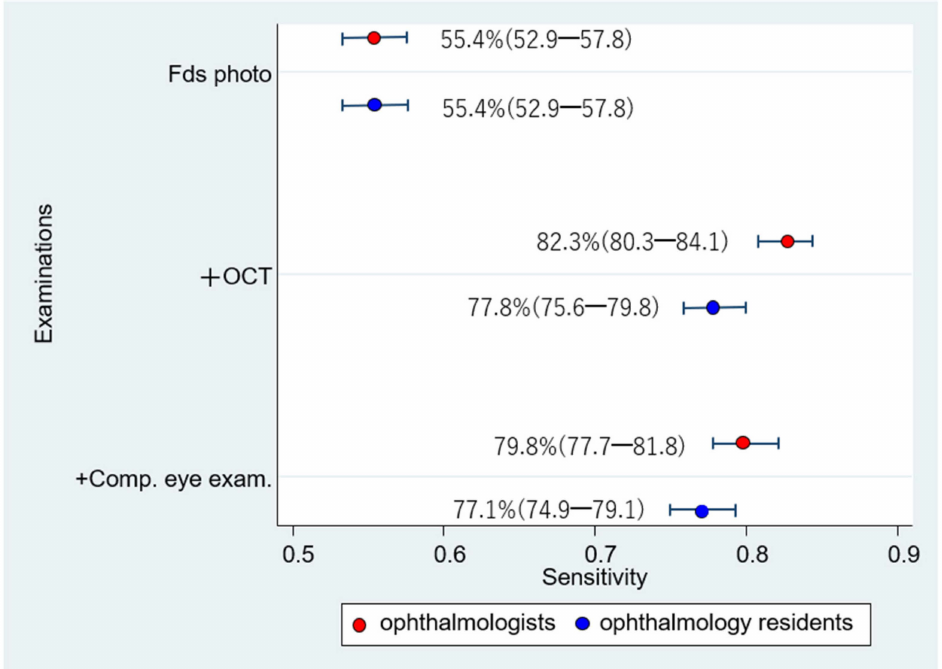
Figure 7. Sensitivity for diagnosis by ophthalmologists and ophthalmology residents. Comparing the sensitivity between ophthalmologists and ophthalmology residents, the sensitivity of ophthalmol- ogists is significantly higher for fundus photography + OCT than that of ophthalmology residents.